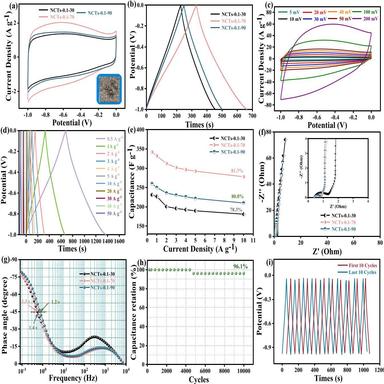
Electrochemical characterization of NCTs-0.1–30/− 70/− 90 in 6 M KOH electrolyte in a three-electrode configuration. (a) CV curves at the scan rate of 5 mV s−1 and inset is the real photograph of developed electrode, (b) GCD curves at the current density of 1 A g−1, (c) CV curves of NCTs-0.1–70 at various sweep rates, (d) GCD curves of NCTs-0.1–70, (e) Specific capacitance as a function of current density, determined in the interval 0.5–10 A g−1, (f) Nyquist plots with fitting curves and corresponding high